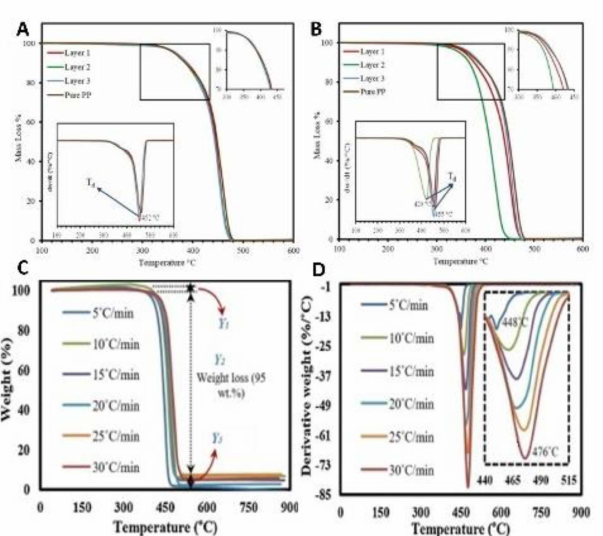
Figure 3. TGA and DTG profiles of various layers: ( A ) N95 respirator and ( B ) surgical mask. Reproduced with permission from Ref. [62]. Copyright 2021 Elsevier Ltd. ( C ) TGA and ( D ) DTG profiles of three-layer surgical mask with various heating rates. Reproduced with permission from Ref. [68]. Copyright 2021 Elsevier